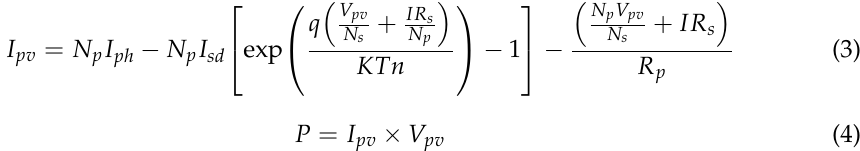
Figure 2. General photovoltaic module model.